Question: How would you classify this visualization?
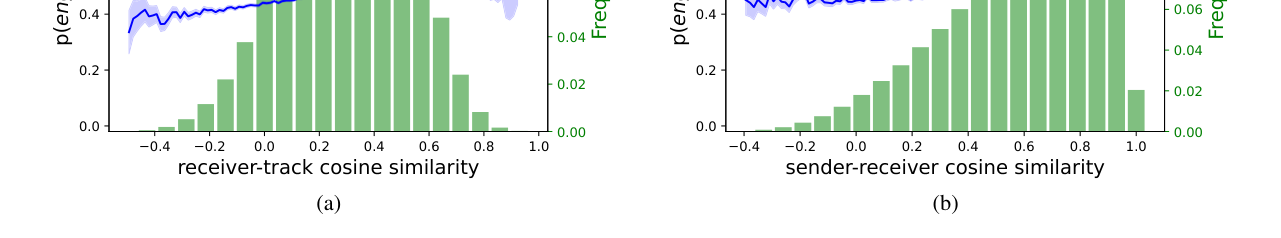
Answer: histogram